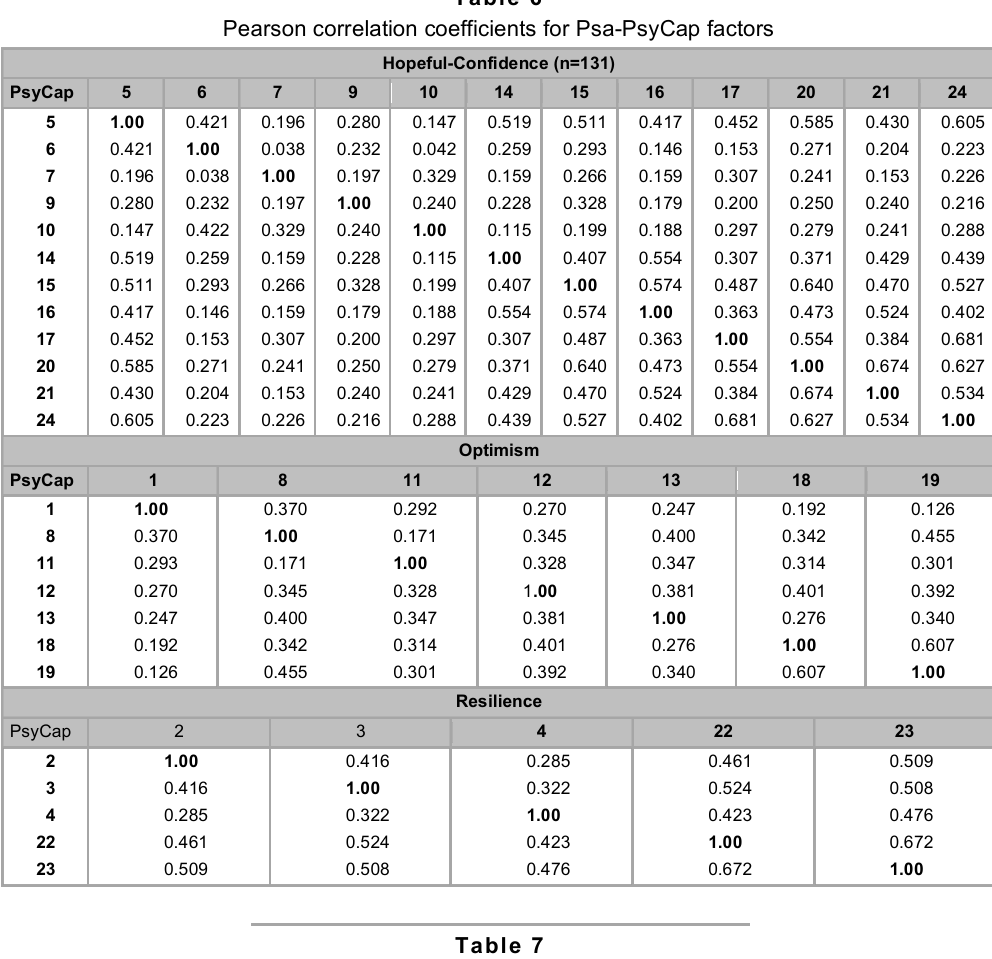
Pearson correlation coefficients for Psa-PsyCap factors Hopeful-Confidence (n=131)